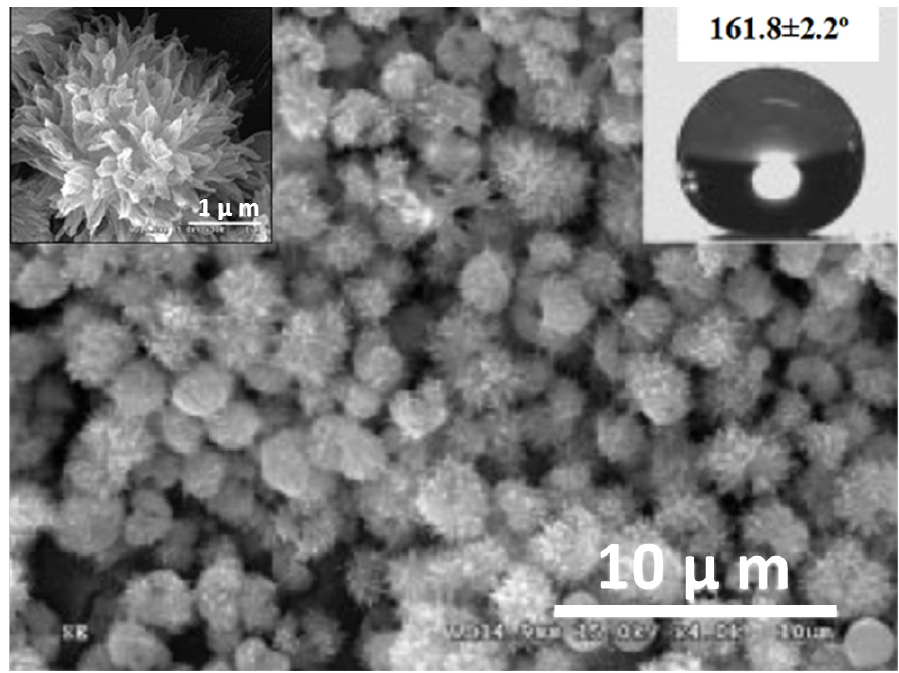
Figure 15. SEM image of coatings cast at room temperature with RH of 75%, left inset shows enlarged view of a single micro-flower on coating and right inset shows the water contact angle on this surface. Images reprinted from [118], with permission from WILEY-VCH Verlag GmbH & Co. KGaA, Weinheim, Copyright 2005.